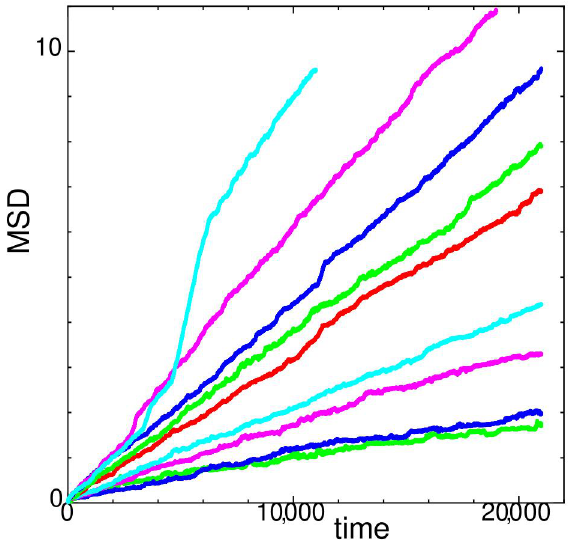
Figure 6. Mean square displacement of state M at temperatures T = 80 (green), 85 (blue), 90 (magenta), 95 (cyan), 98 (red), 100 (green), 102 (blue), 104 (magenta), and 105 (cyan) for system size N = 5376. Lower values of MSD for lower temperatures when data plotted with the same